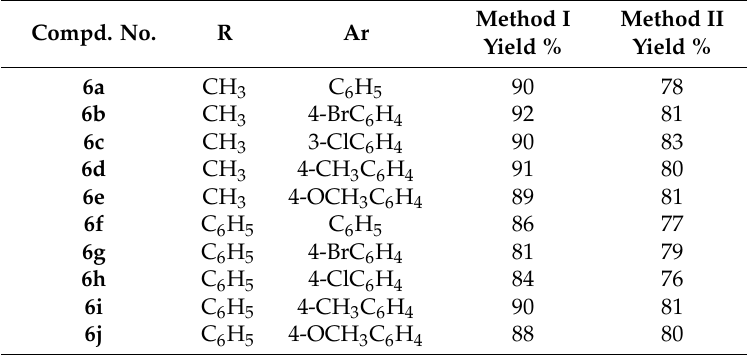
Table 2. Yield comparison between triethylamine (Method I) and dry ammonia (Method II). Compd.